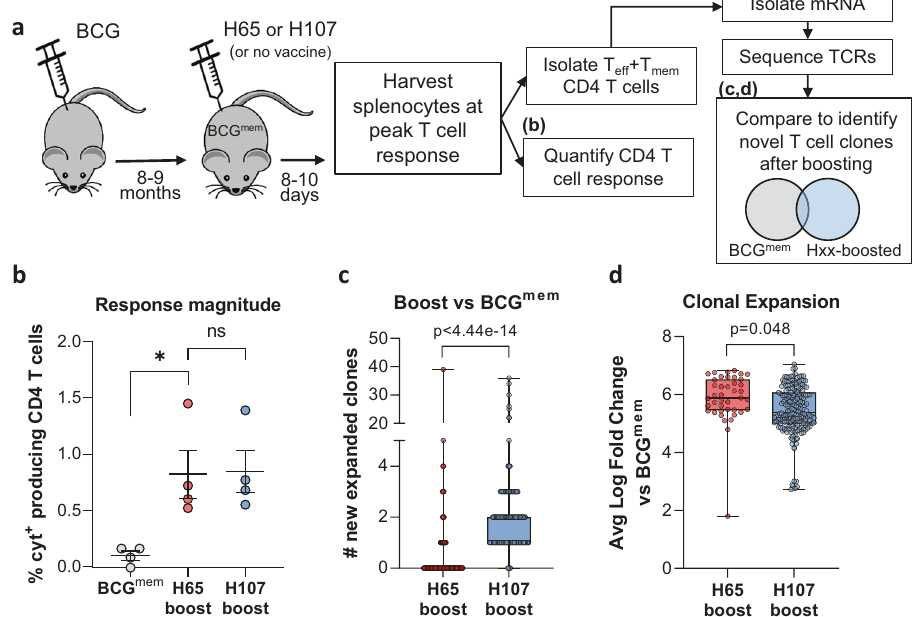
Fig. 4 H107 induces novel T cell clones in BCG memory mice. a Experimental setup in which CB6F1 mice were immunized s.c. with BCG and rested eight- nine months to create memory mice (BCG mem ). BCG mem mice were then boosted by immunizing three times with H65/CAF ® 01 or H107/CAF ® 01 at 2-week intervals and analyzed 8 – 10 days after fi nal immunization for CD4 T cell response magnitude via intracellular cytokine staining (ICS) and clonal expansion versus nonboosted BCG mem controls via TCR mRNA sequence analysis. b Percentage of cytokine-producing (IFN- γ , IL-2, TNF, and/or IL-17A) CD44 high CD4 T cells after ex vivo restimulation of splenocytes with recombinant H65 or H107 protein 8 days after fi nal subunit immunization. Line, meam ±SEM; symbols, individual mice ( n = 4/grp). One-Way ANOVA with Tukey ’ s Multiple Comparison test, BCG mem vs. H65-boost p = 0.0307. c The number of new T cell clones de fi ned by comparison of TCR- β V-J pairings identi fi ed in puri fi ed T mem /T eff CD4 T cells from BCG mem animals with 5 µ g H65-